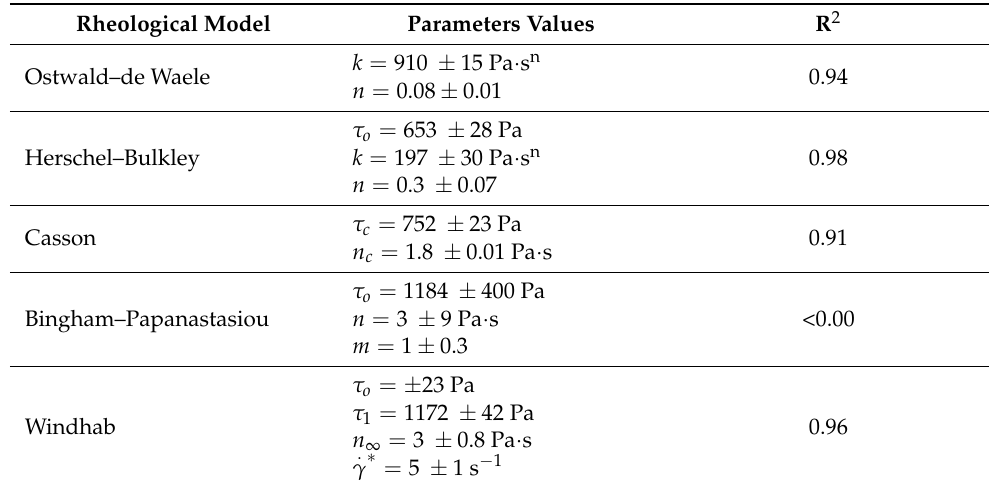
Table 5. Identification of the parameters of the rheological used models for